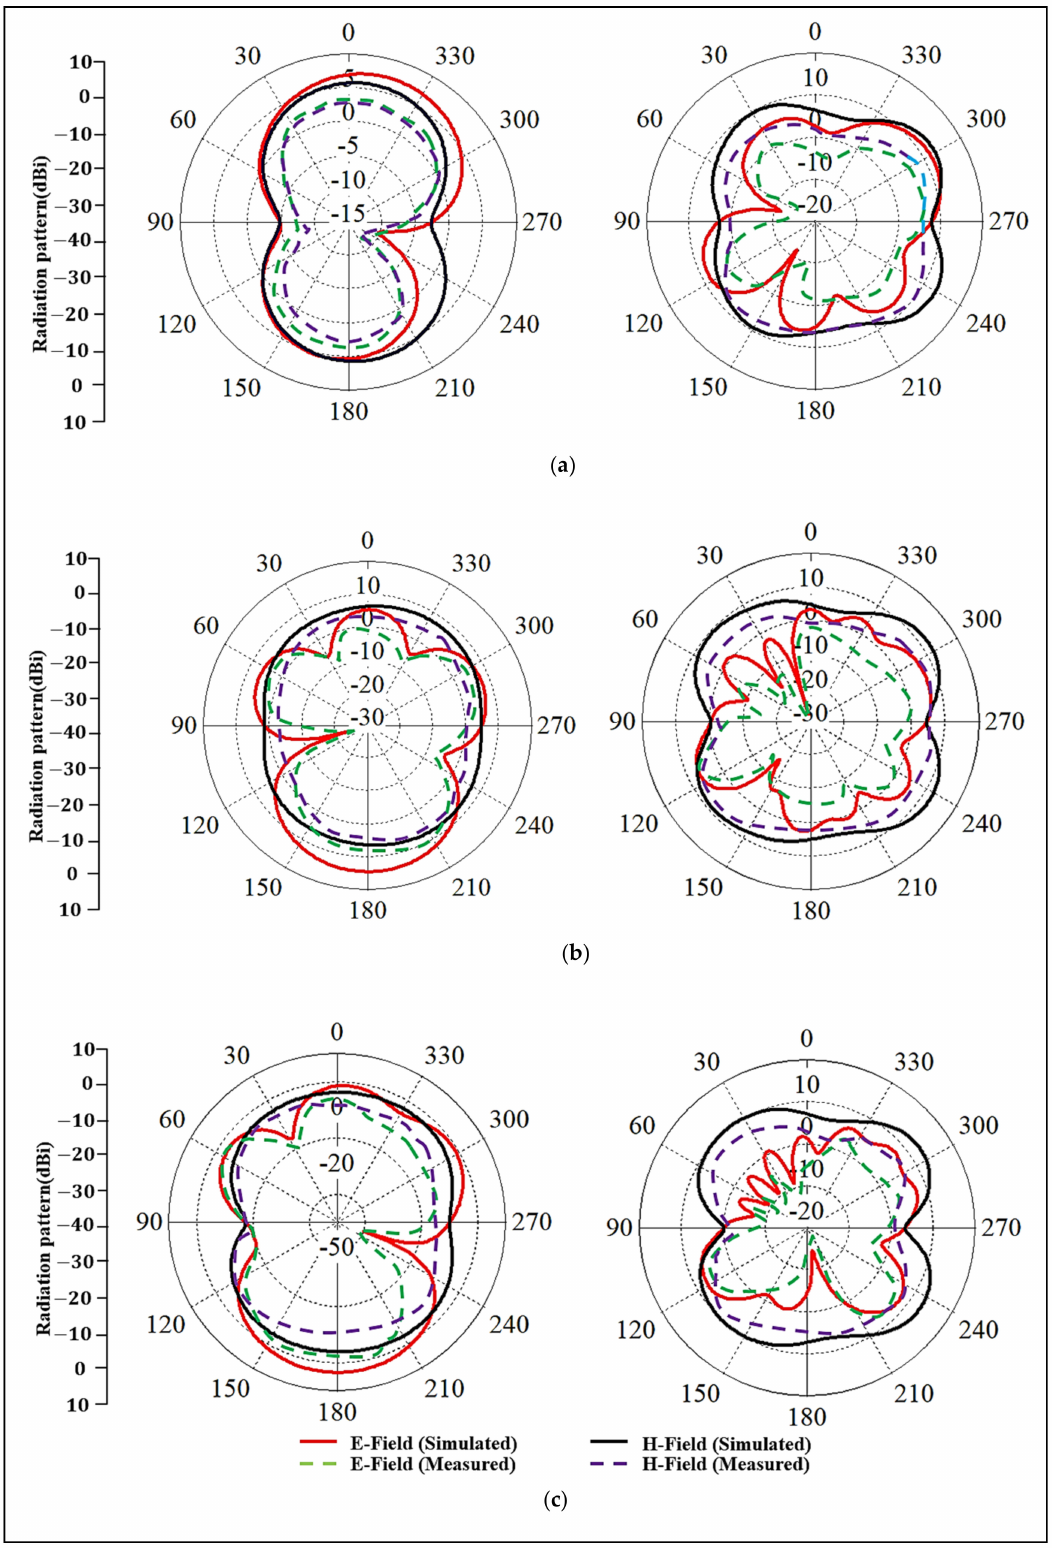
Figure 10. Simulated and measured radiation patterns of E and H planes at both bands, left side: the lower frequency, right: the higher frequency, ( a ) free-space (2.2 GHz and 5.6 GHz), ( b ) on-chest (2.3 GHz and 5.7 GHz), ( c ) on-arm (2.2 GHz and 5.7